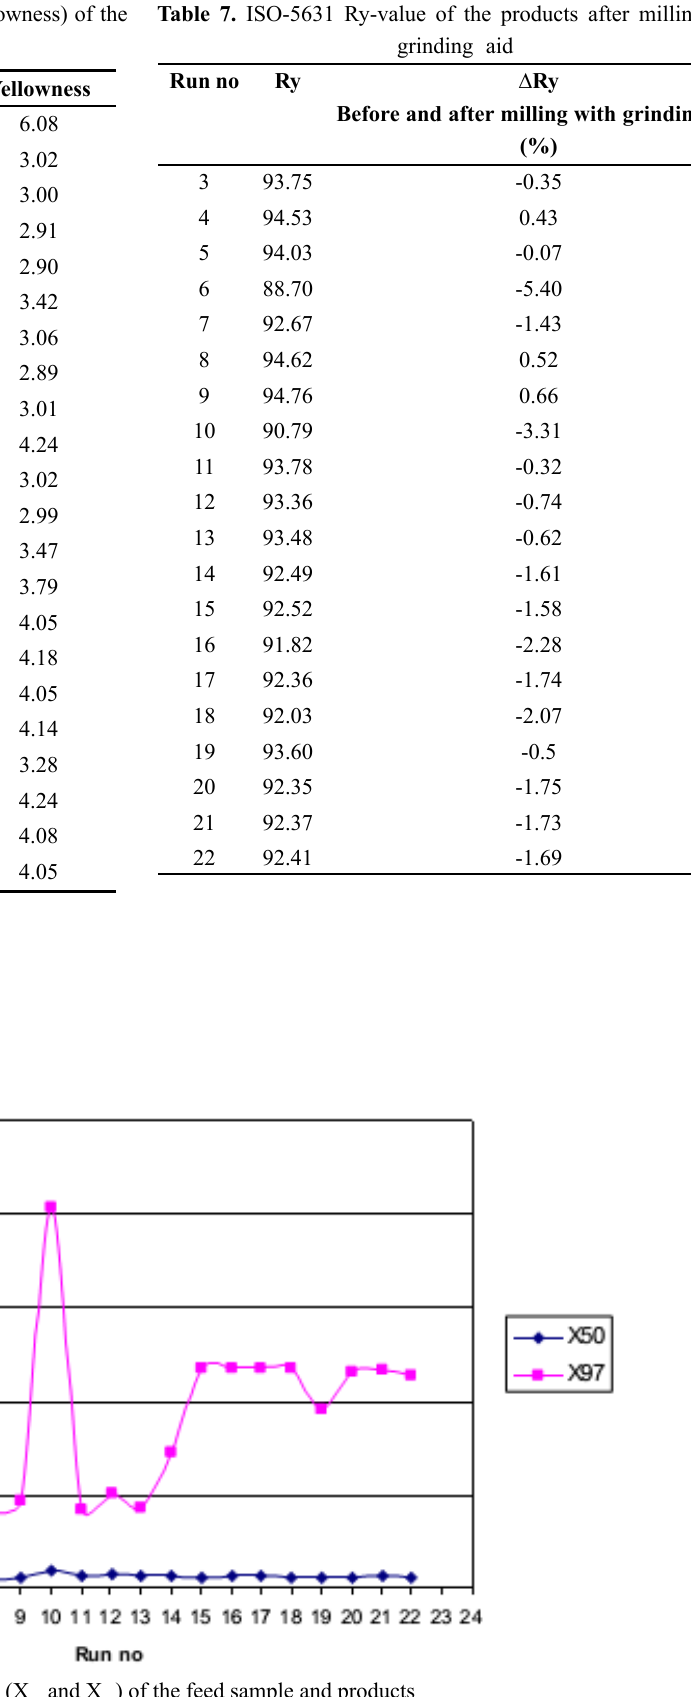
Fig. 2 . Particle size (X